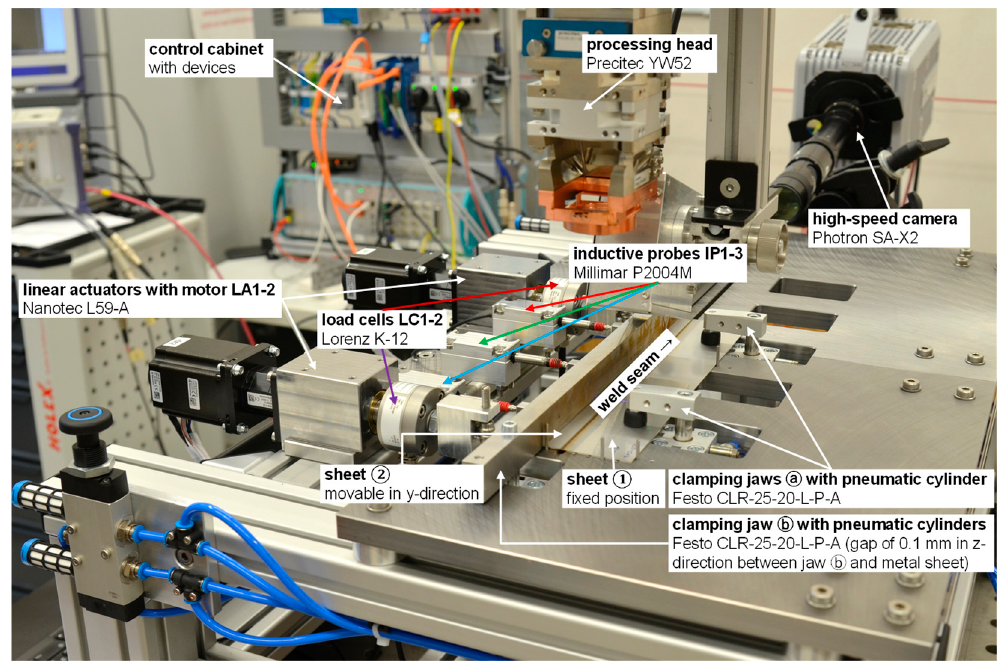
Figure 4. Realization of adaptive clamping device in laser welding setup (housings of load cells and actuators removed).